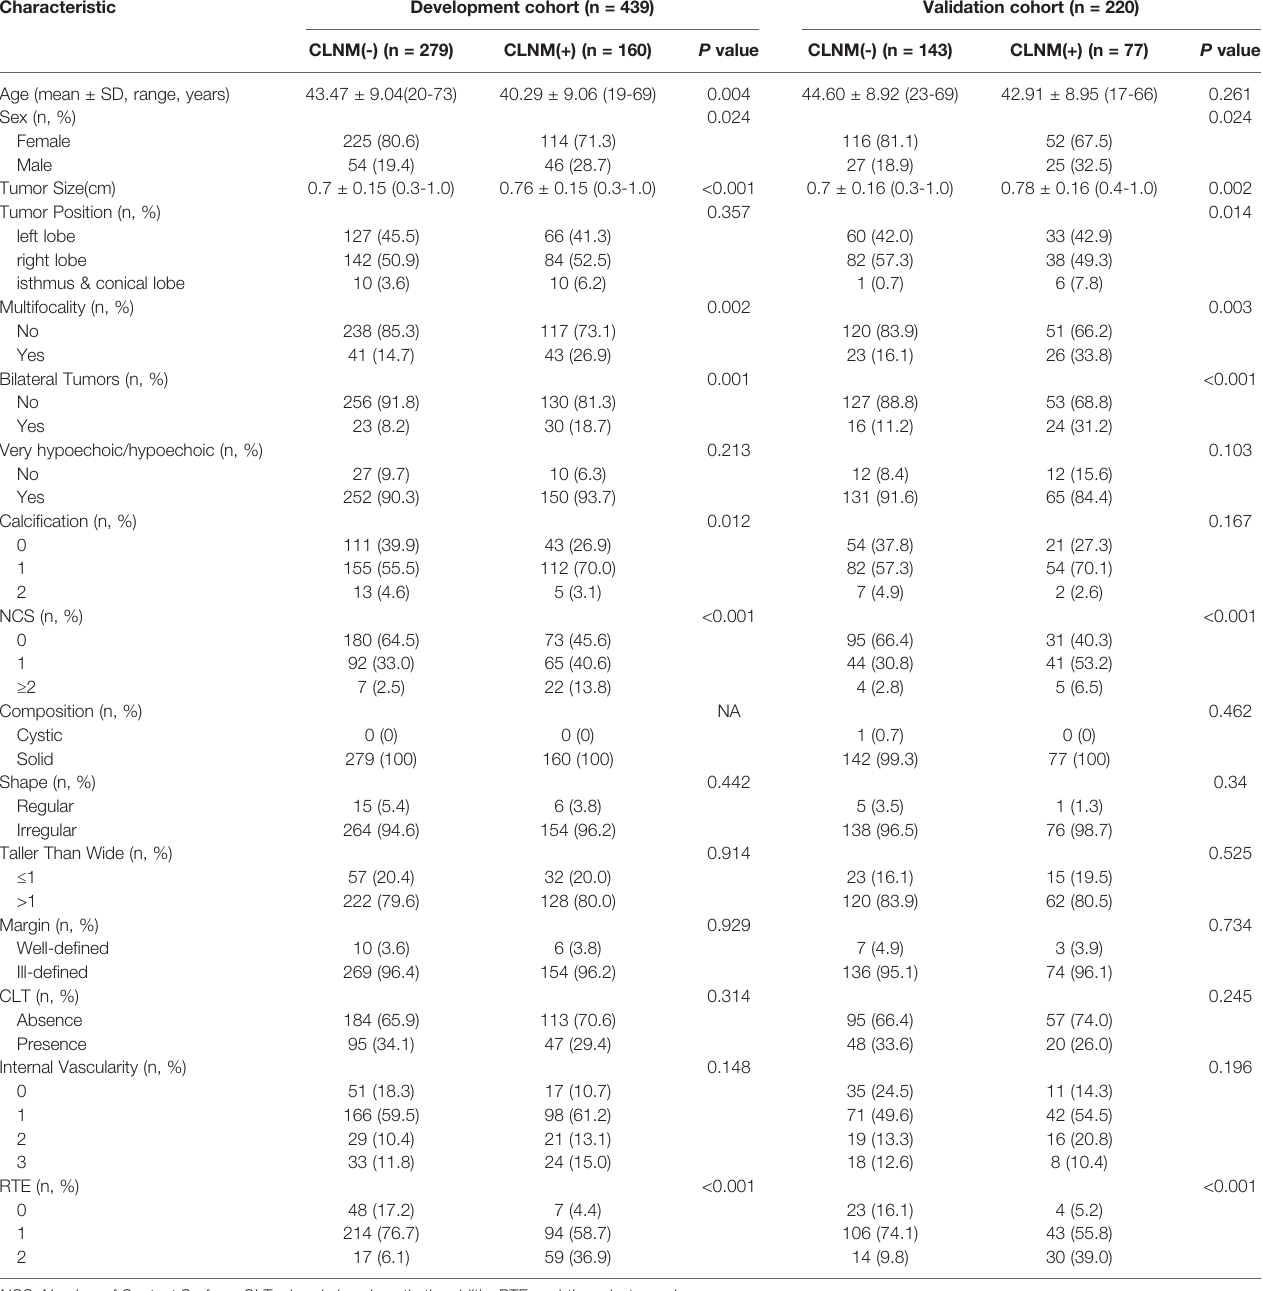
Table 1 concludes the US features and clinical characteristics of the patients in the development and validation set. The positive rates of CLNM in the development and validation sets were 36.4% and 35% individually. Hence, the prevalence of CLNM in the two datasets had no signi fi cant difference ( P =0.715). In TABLE 1 | Clinical and US features of patients in the development and validation cohorts.